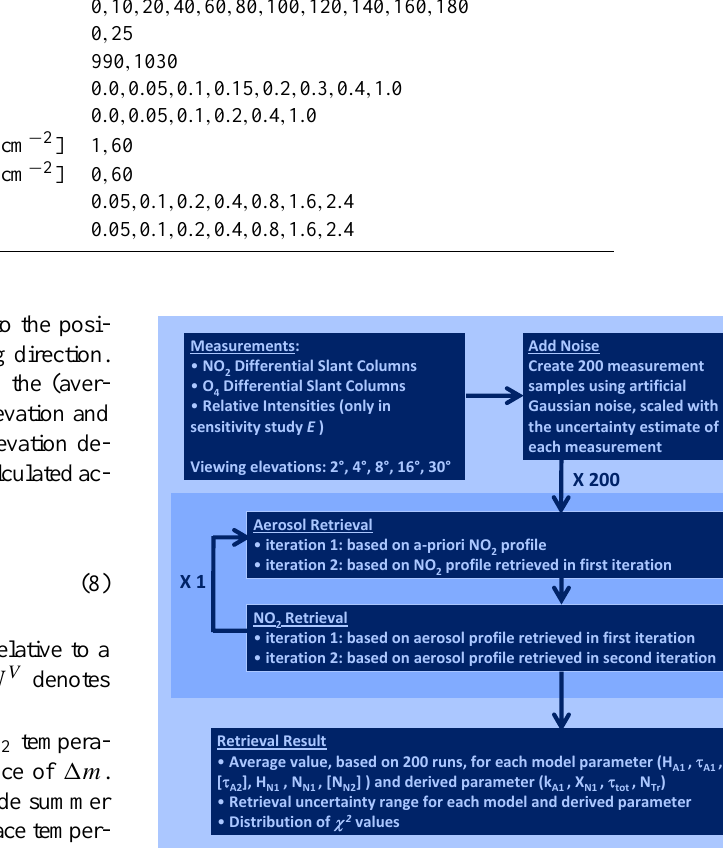
Fig. 3. Schematic of the tropospheric aerosol and NO 2 retrieval algorithm. This algorithm is used both in the sensitivity study (using simulated measurements) and in the analysis of measurements taken during the CINDI